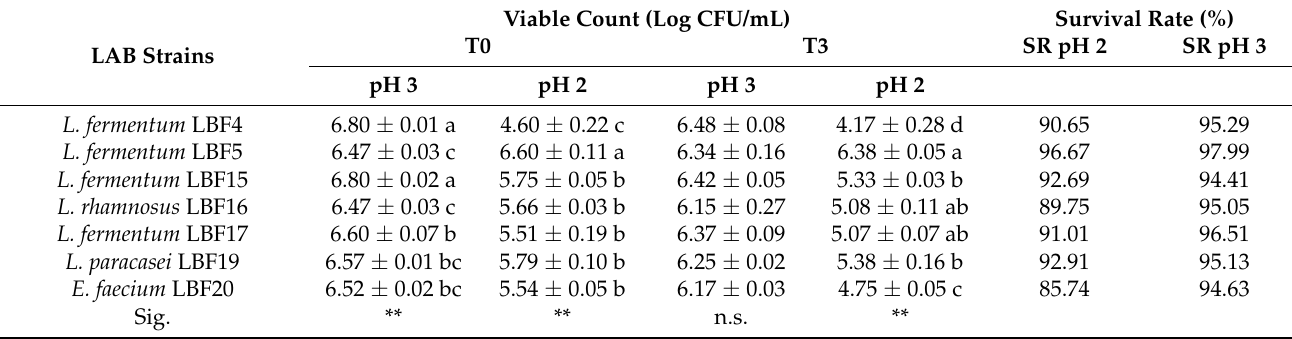
Table 1. Tolerance to acidic